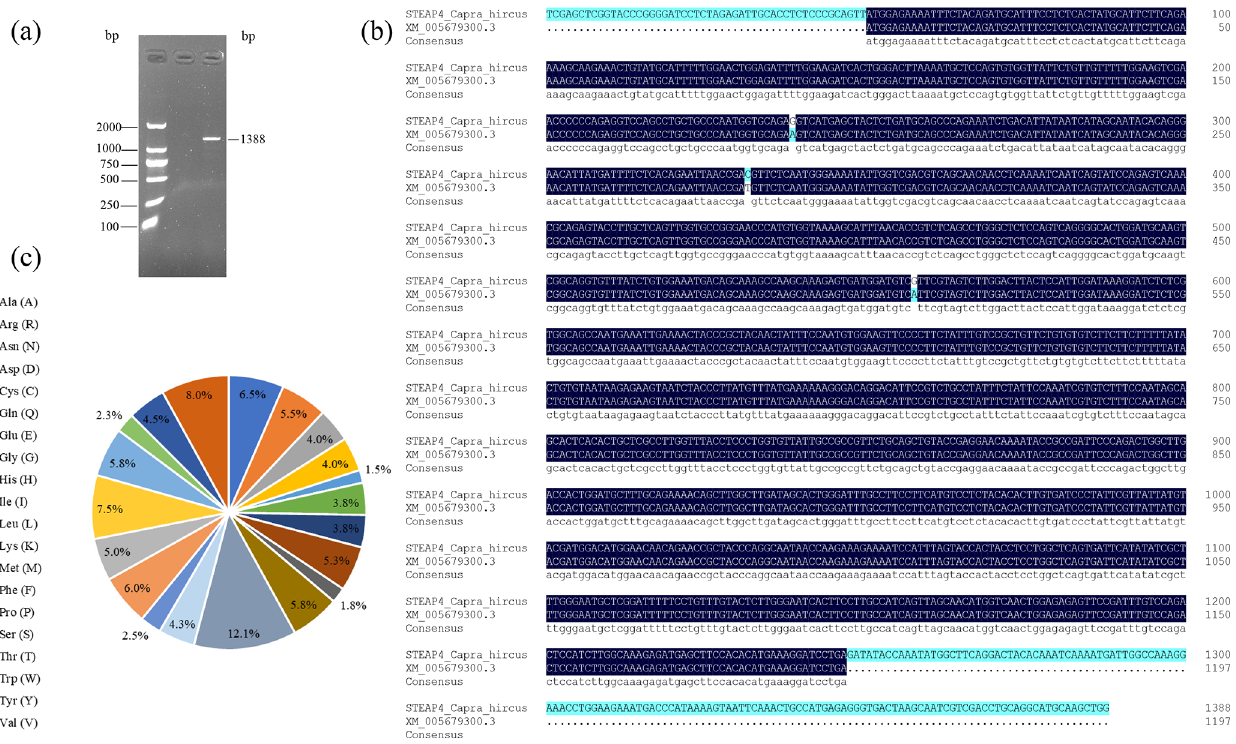
Figure 1. Sequence analysis of the goat STEAP4 gene. (a) Goat STEAP4 gene amplification results. (b) STEAP4 gene sequence alignment with predicted sequence. (c) Amino acid composition of STEAP4